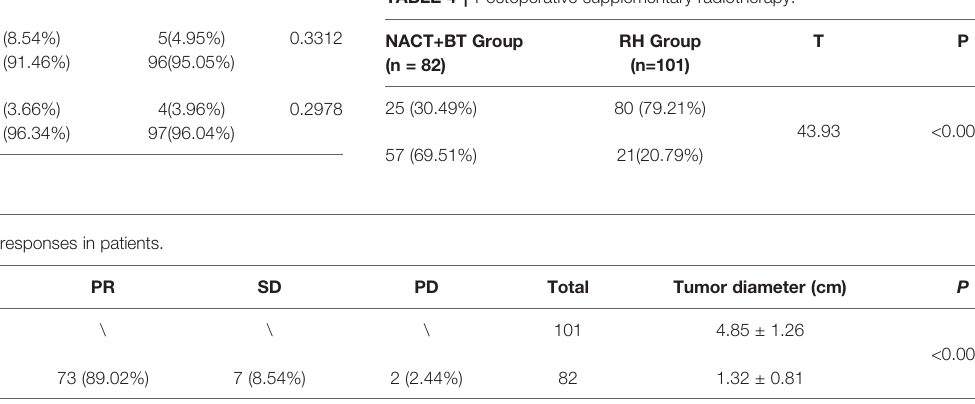
TABLE 4 | Postoperative supplementary radiotherapy.